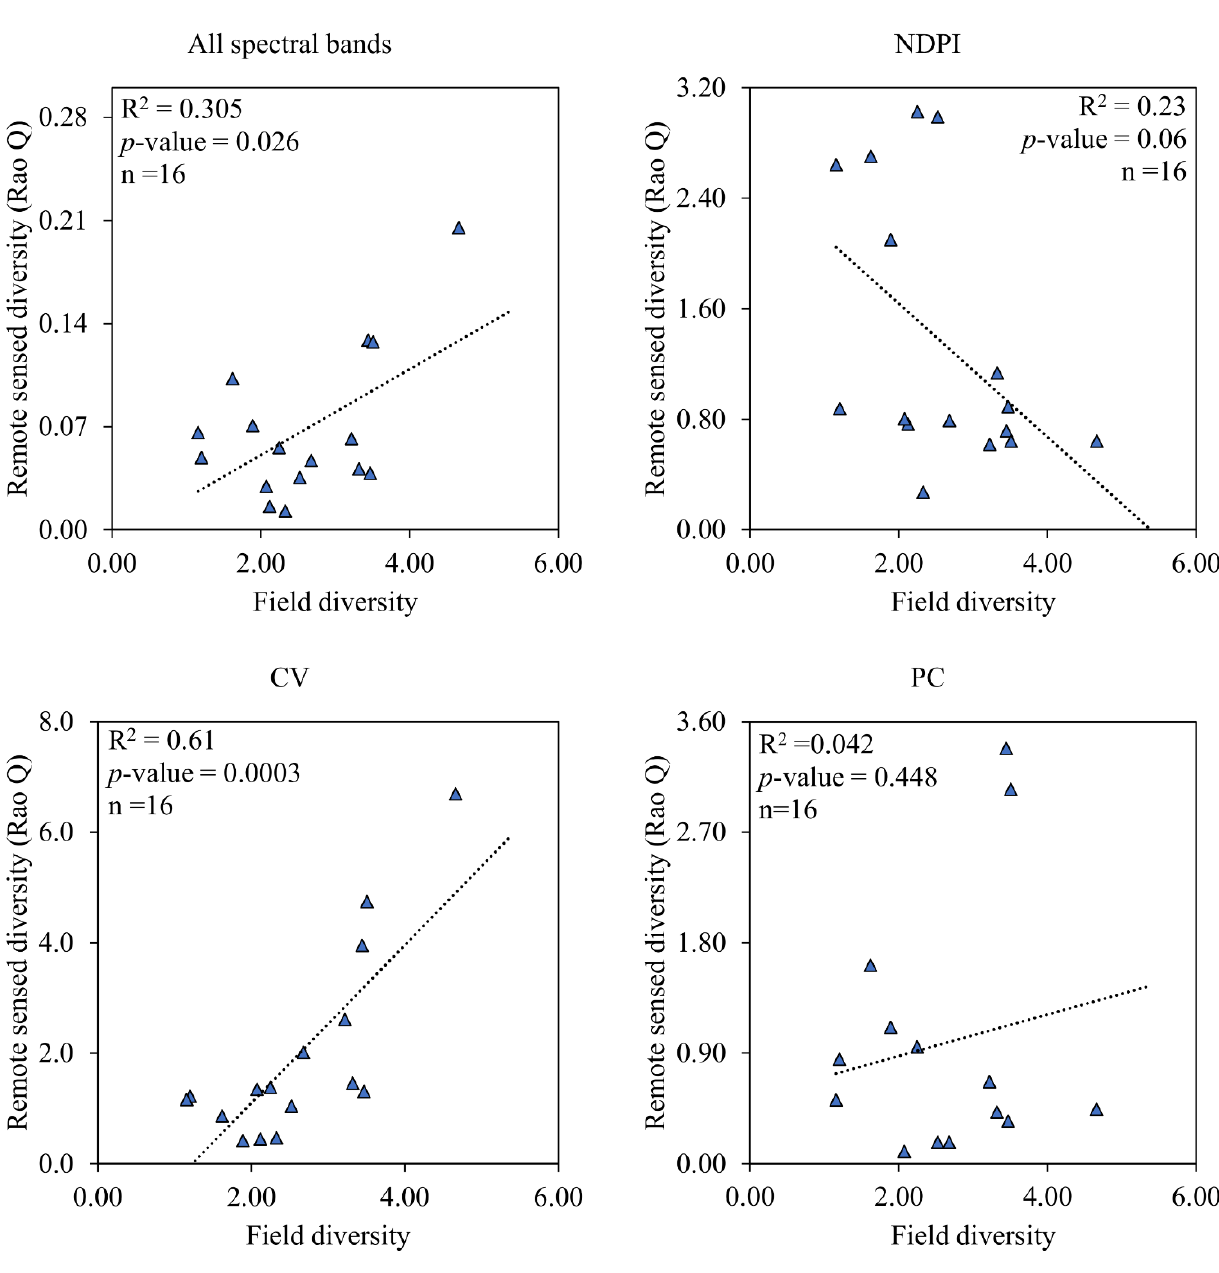
Figure 6. Linear regression of field-measured vegetation diversity and remote sensed diversity (Rao’s Q) in our study area. Remote sensed diversity (Rao’s Q) was derived from 20 m spatial resolution for all the spectral bands, the Normalised Difference Phenology Index (NDPI), the Coefficient of Variation (CV), and the first Principal Component (PC).